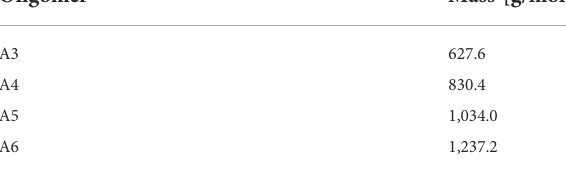
TABLE 1 Molar masses of oligomers. Molar masses of fully acetylated trimer to hexamer (A3 – A6) used for conversion of LC-MS data.